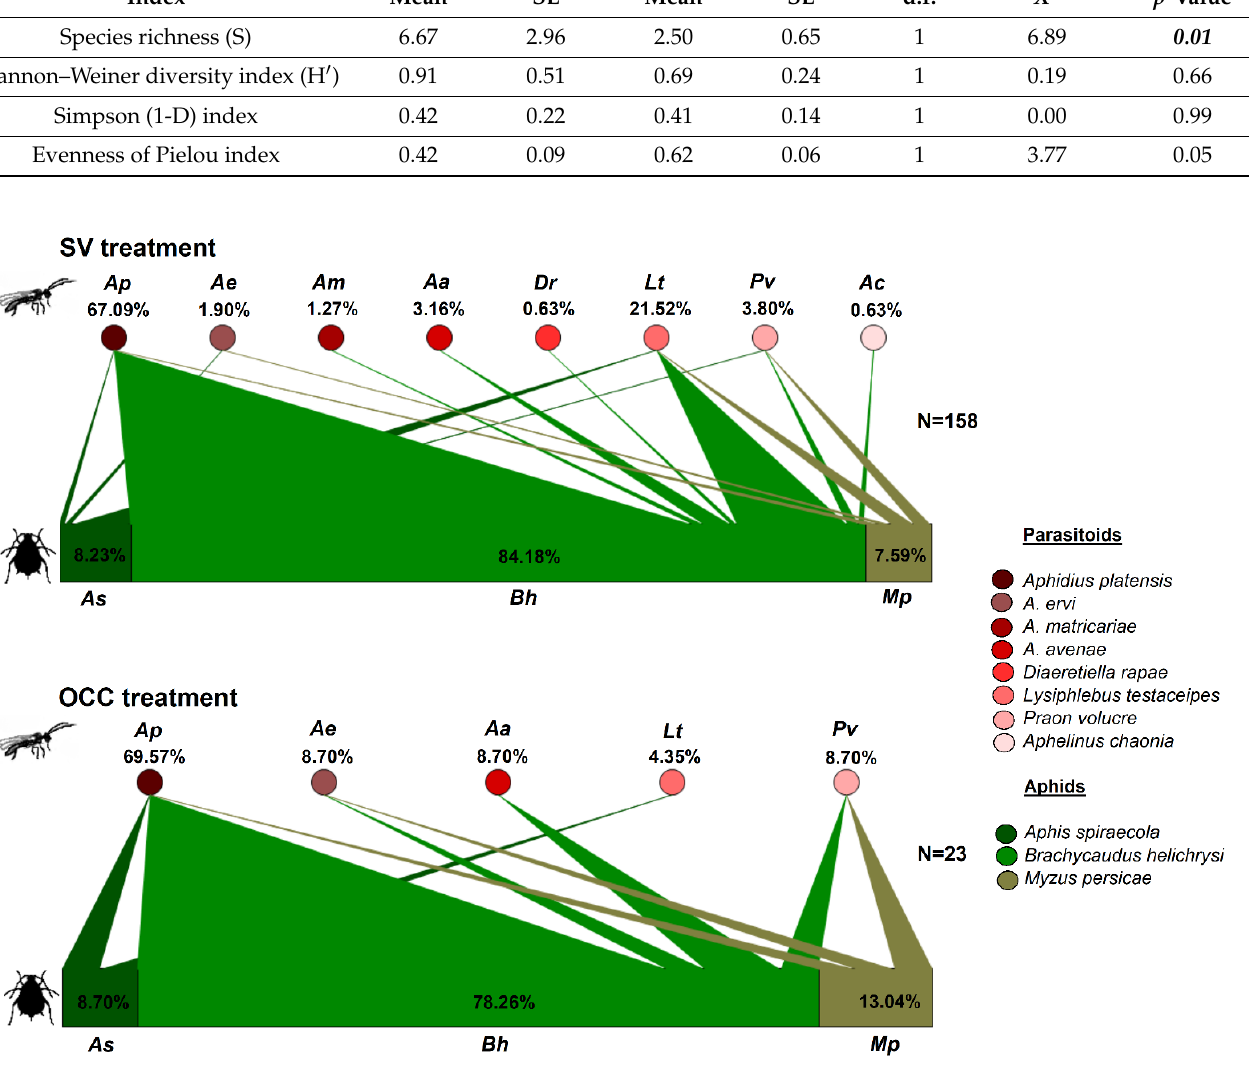
Figure 1. Quantitative food webs of aphids–primary parasitoids during spring in plum orchards in Chile comparing two treatments: Spontaneous vegetation (SV) and oat cover crop (OCC). The horizontal bars represent the relative abundances of each aphid species parasitized ( lower bars) and their primary parasitoids ( upper circles). The arrows represent the strength of interaction (% relative abundances) between each aphid host–parasitoid combination. N = corresponds to the number of adult parasitoids emerged in all samples (unparasitized aphids were not considered). Table 1. Summary of diversity indices between the spontaneous vegetation (SV) and the oat cover crop (OCC) treatments for all parasitoids present. In addition, generalized linear models (GLMs) show statistical differences among treatments for each of the indices evaluated.